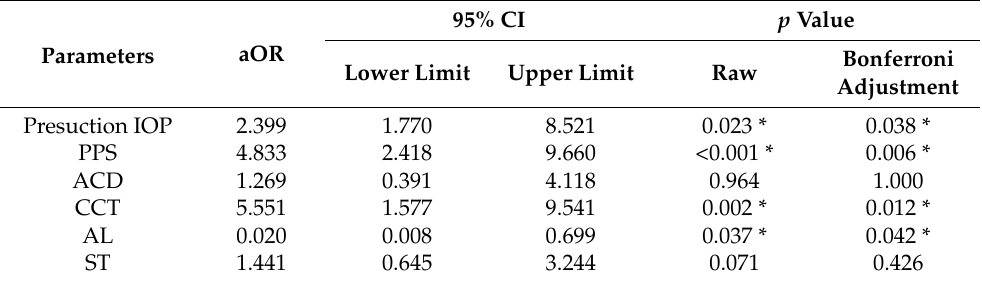
Bonferroni Adjustment